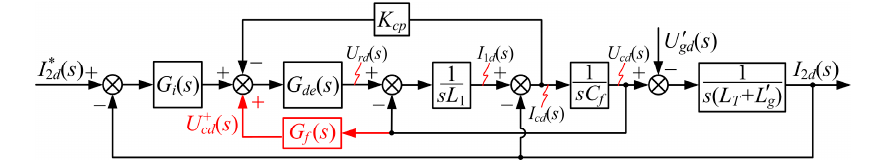
Figure 3. d -axis control block of grid current.